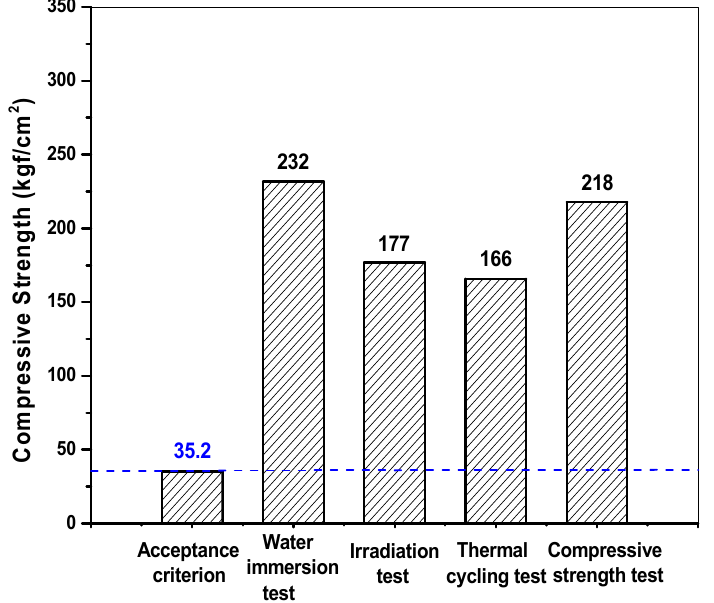
Figure 8. Comparison of compressive strengths of the representative samples of waste-form drums after each test (0.35 of w/c and 11 wt.% of spent resin).